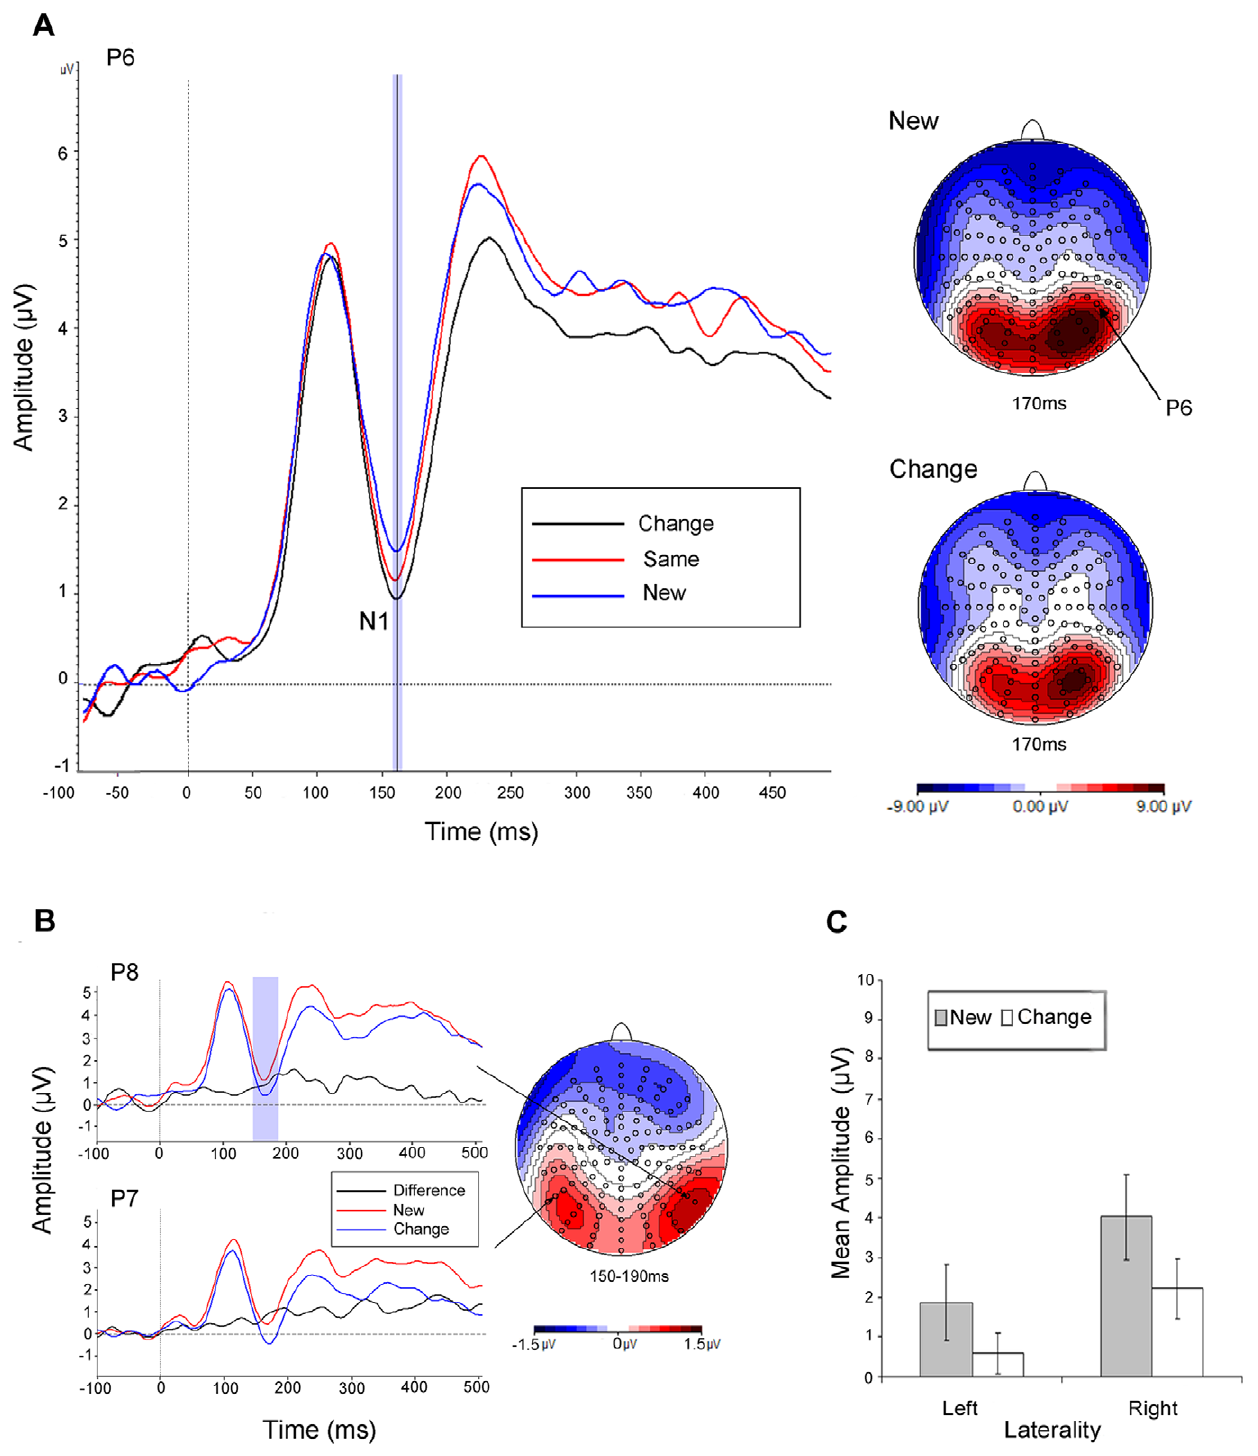
Figure 1. ERP Shape repetition effects. (a) Grand average ERPs to new (blue line) versus change (black line) stimuli plotted between 2 100 and 500 msec, with respective topographies for the N1 at peak amplitude; (b) topography associated with the difference in mean amplitude for the new versus change contrast over the highlighted 40 msec epoch for the N1; (c) mean amplitudes across posterior electrode clusters during the N1 as a function of laterality and transformation.